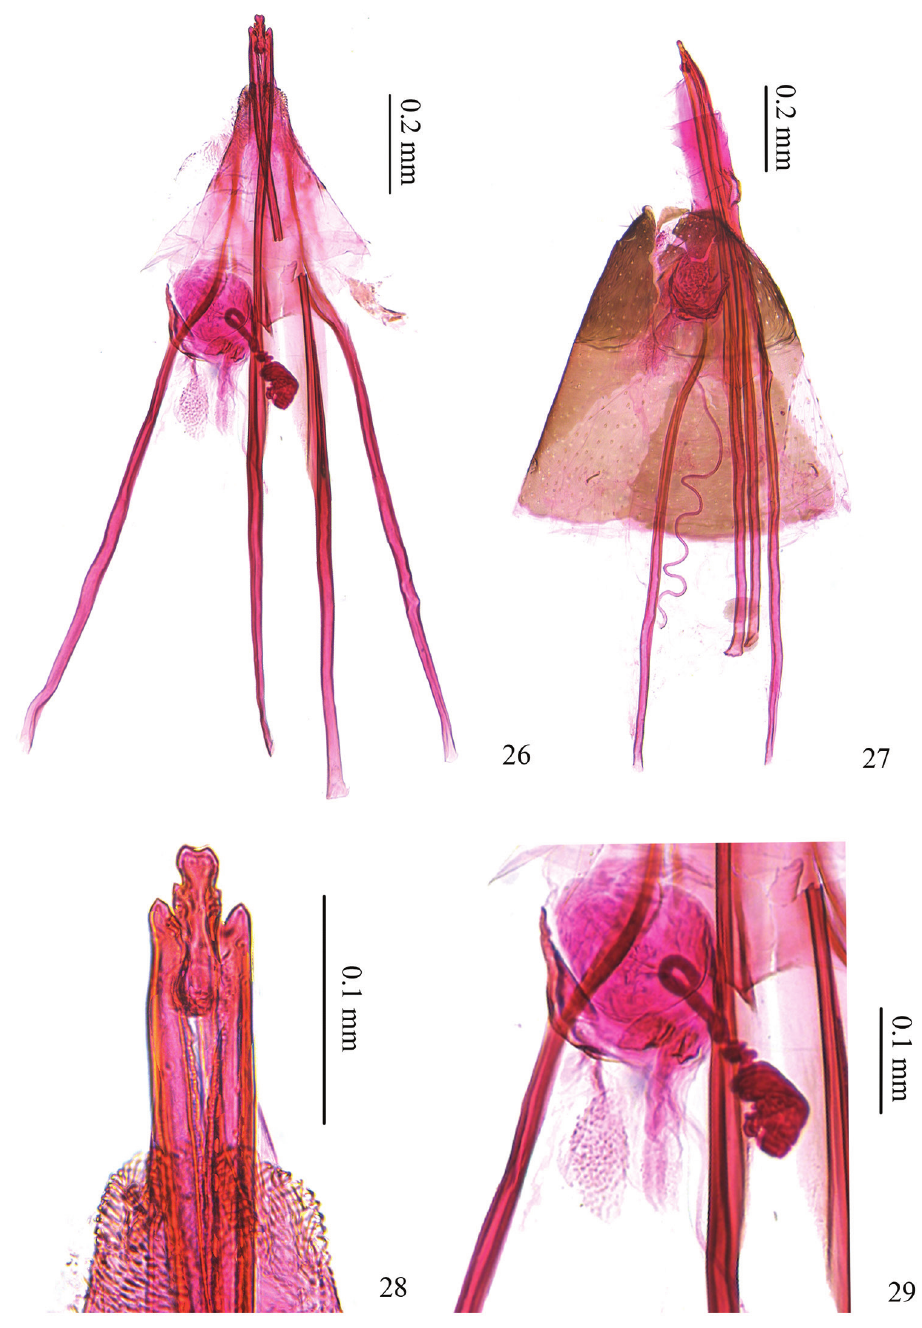
Figures 26–29. Female genitalia of Antispila kunyuensis . 26 female genitalia, SDNU.LIU0016 27 fe- male genitalia, SDNU.LIU0013 28 detail of ovipositor tip, same slide as 26 29 detail of vestibulum, same slide as